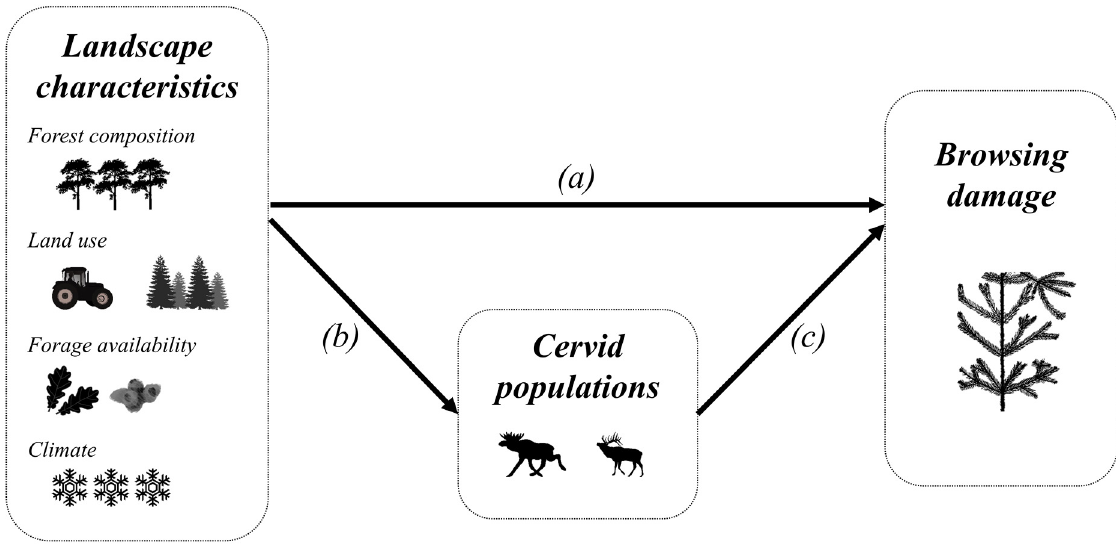
Figure 1. Conceptual model illustrating the potential direct and indirect effects between landscape characteristics , cervid populations , and browsing damage . Landscape characteristics can directly affect browsing damage (path a) and cervid populations (path b). At the same time, cervid populations can directly affect browsing damage (path c), whereby landscape characteristics may have additional indirect effects (path b + c) on browsing damage mediated by cervid populations .